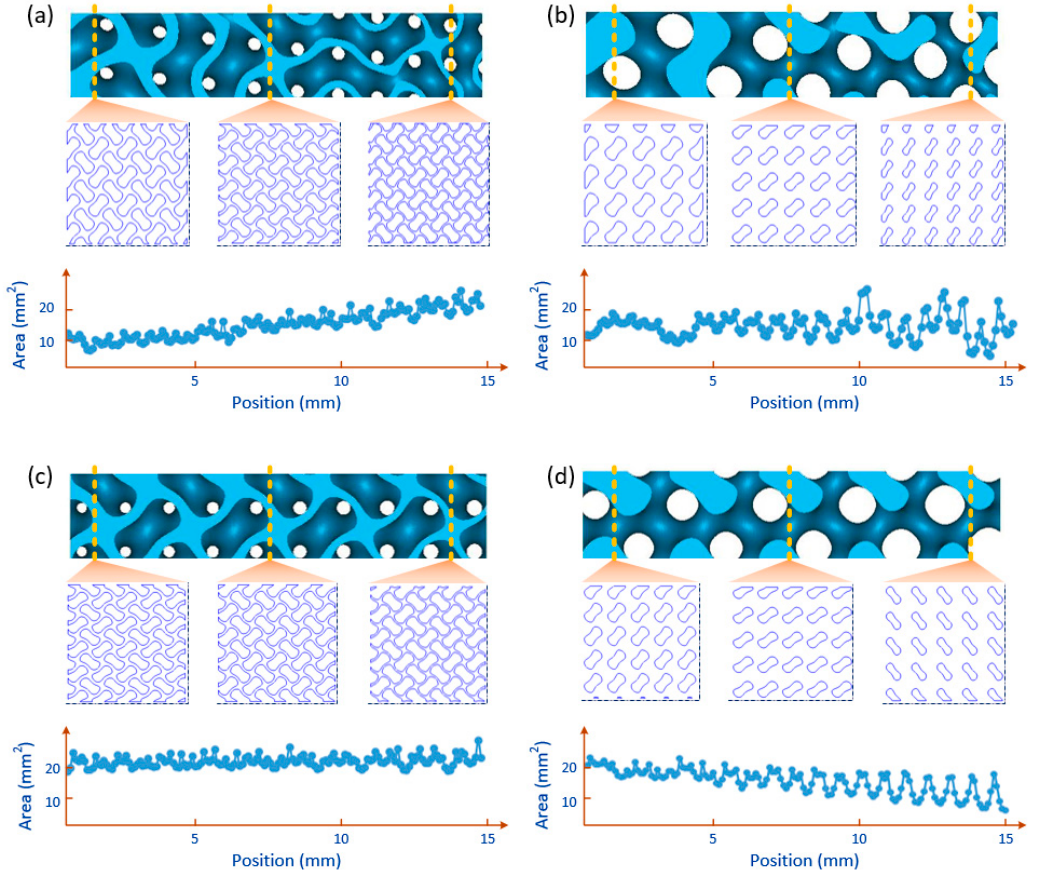
Figure 5. Analysis and comparison of surface area for different types of FGS based on a slice method: ( a ) SP, ( b ) NP, ( c ) SC, and ( d ) NC.